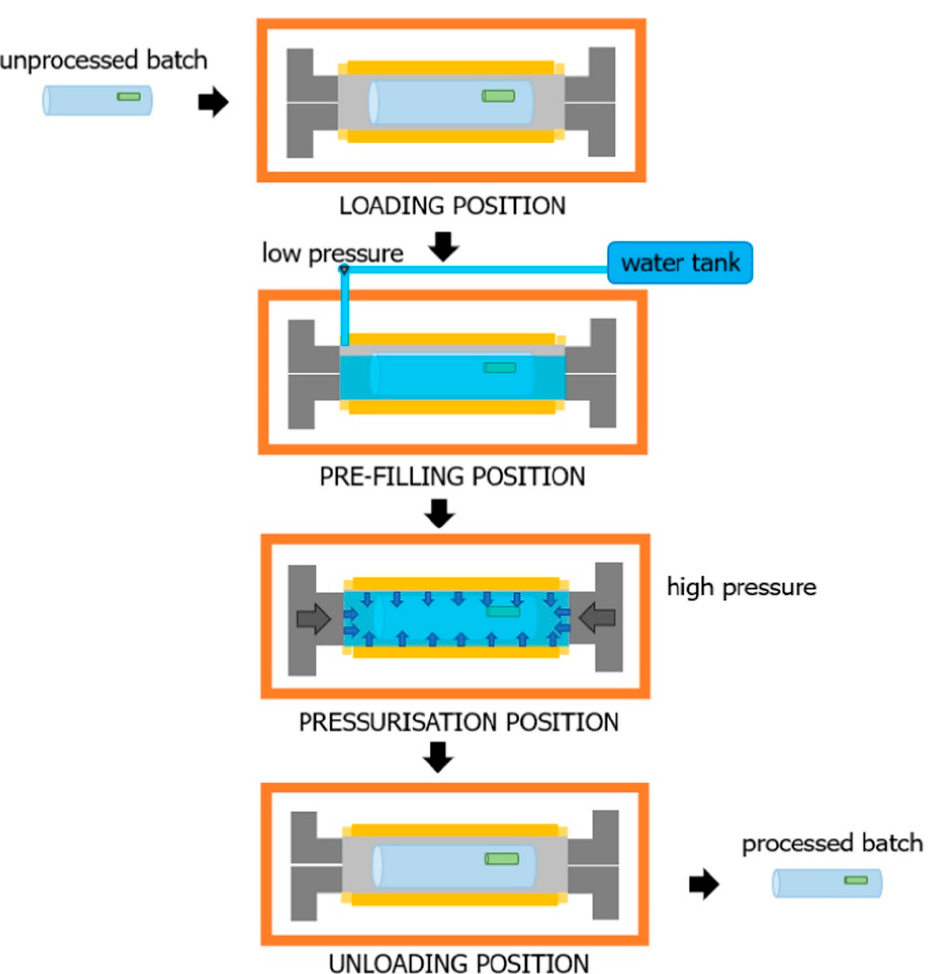
Figure 1. Diagram representing high-pressure processing (HPP) treatment of a pre-packed food (extracted from EFSA BIOHAZ Panel, European Food Safety Authority Panel on Biological Hazards, 2022) [5].